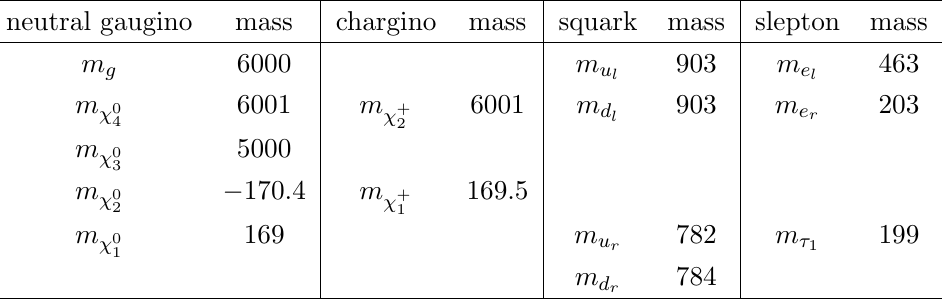
Table 3 . A benchmark spectrum with Heavy squarks, lighter sleptons, and a Higgsino (N)LSP. mediated scenarios, where we expect a light Higgs boson, the light neutralino decays to a Higgs or gauge boson and a gravitino. This means that gauge mediated decay chains have the interesting property of containing electroweak gauge bosons or Higgses in the (cid:12)nal state. Below I give an example spectrum which had a Higgsino-like neutralino